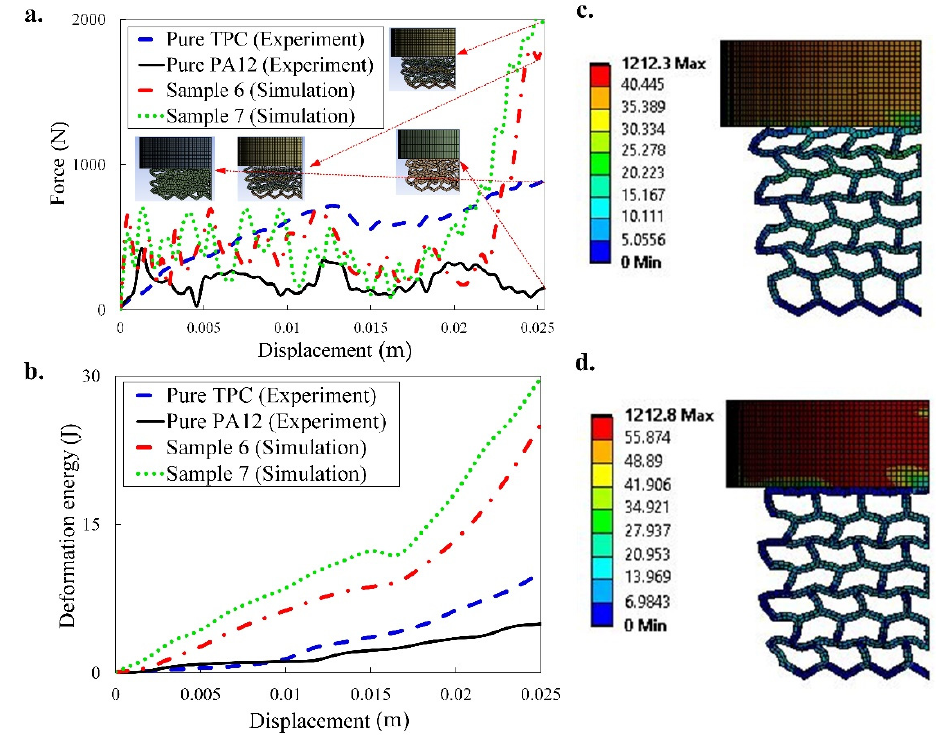
Figure 9. Numerical uniaxial force-displacement response ( a ), deformation energy absorption ( b ) and von Mises stress contour (in MPa) at state III ( c , d ) of the PA12-TPC (sample 6) and TPC-PA12 (sample 7), respectively, in comparison with the experimental results of pure TPC and PA12 under quasi-static compression test (see Figure 2 for the difference between the two samples).